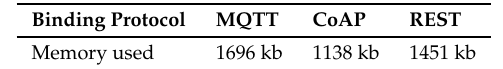
Table 3. Maximum RAM memory use of the IoMT device for each BP